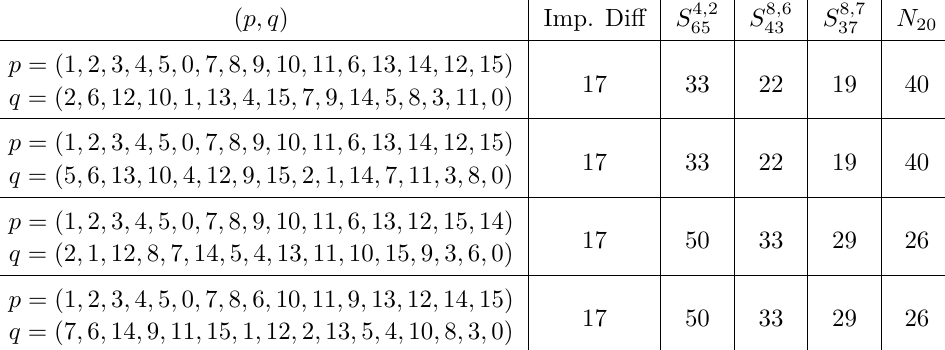
Table 6: Security evaluation for the best equivalence classes with k = 16 ( p, q ) Imp. Diff S 4 , 2